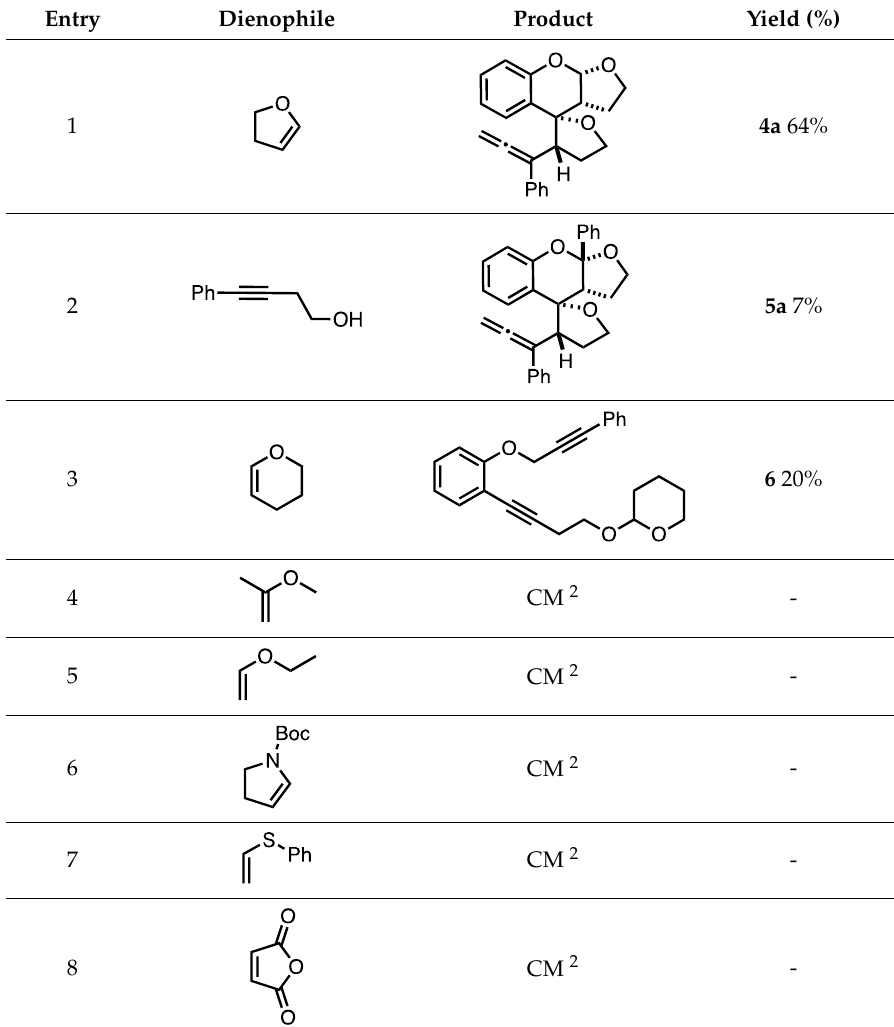
Table 1. Optimization of the reaction conditions. 1